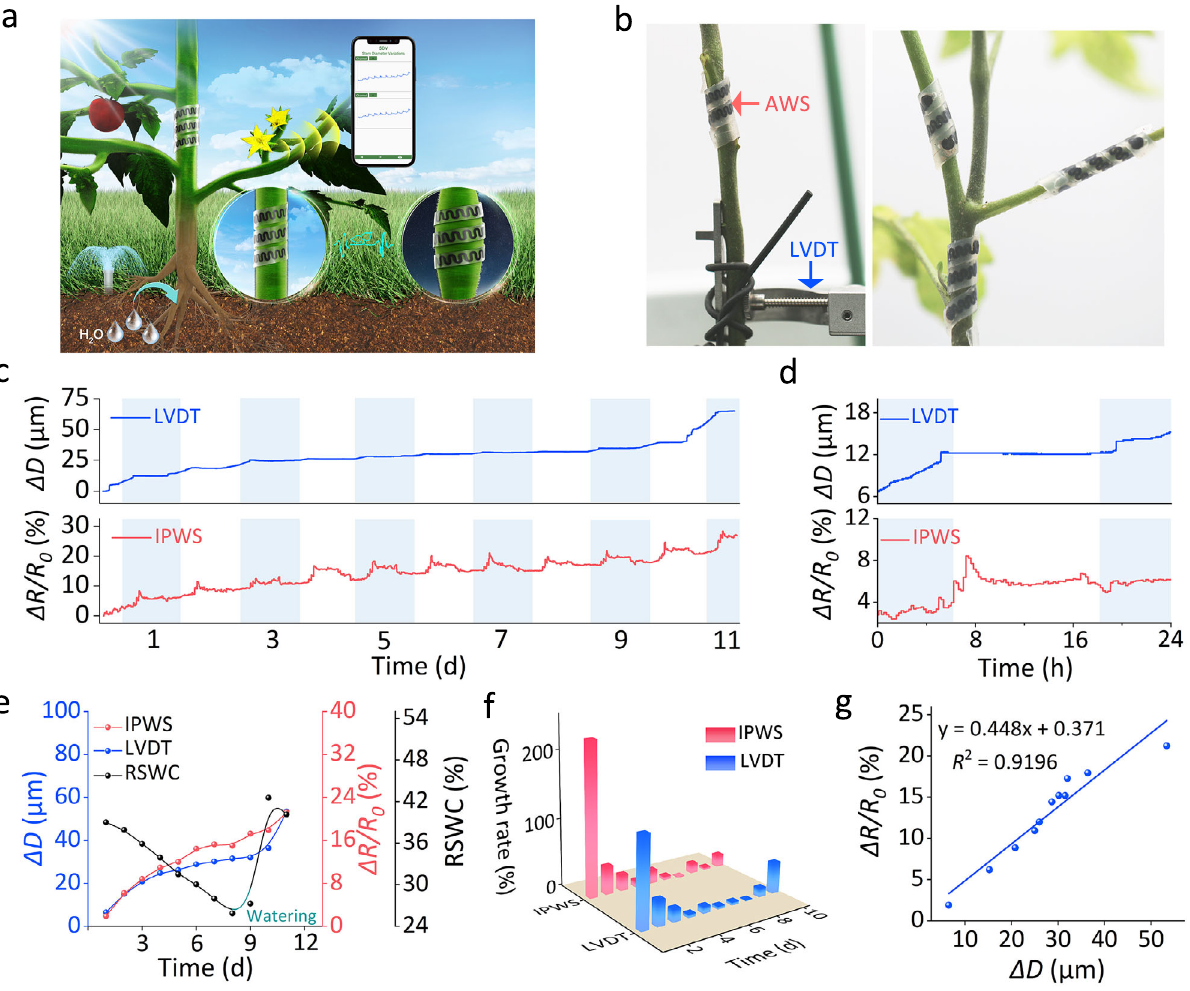
Fig. 6 In vivo monitoring of plant pulse. a Schematics of the IPWS for plant pulse monitoring with smartphone for continuous data readout. b The optical images of AWS sensor and commercial LVDT sensor on tomato stem. c 11 days of monitoring curves obtained from IPWS and reference sensor. d The monitoring curves on the 2 nd day. e The soil moisture data and stem monitoring data. f The stem expansion rate measured by the IPWS and reference sensor. g The linearity between the SDV measured by the reference sensor and the resistance variation rate measured by